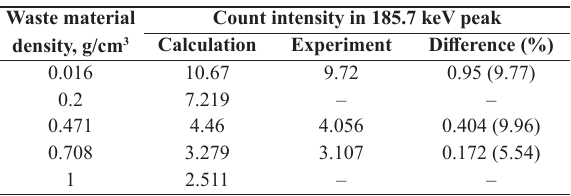
Table 2. Count intensity in the 185.7 keV peak with the back- ground deduction for different cellulose densities in the cask (experiment: 0.313 g of 235 U, 4.81 g of uranium; calculation: 1 g of 235 U, 20 g of uranium)